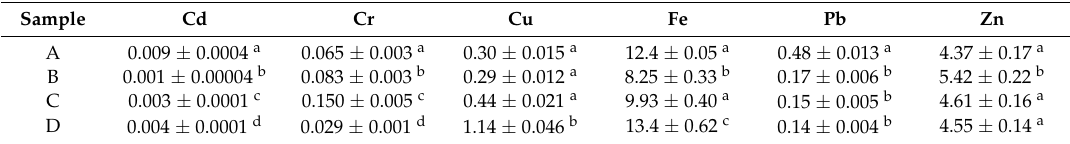
Table 3. The content of elements in the soil